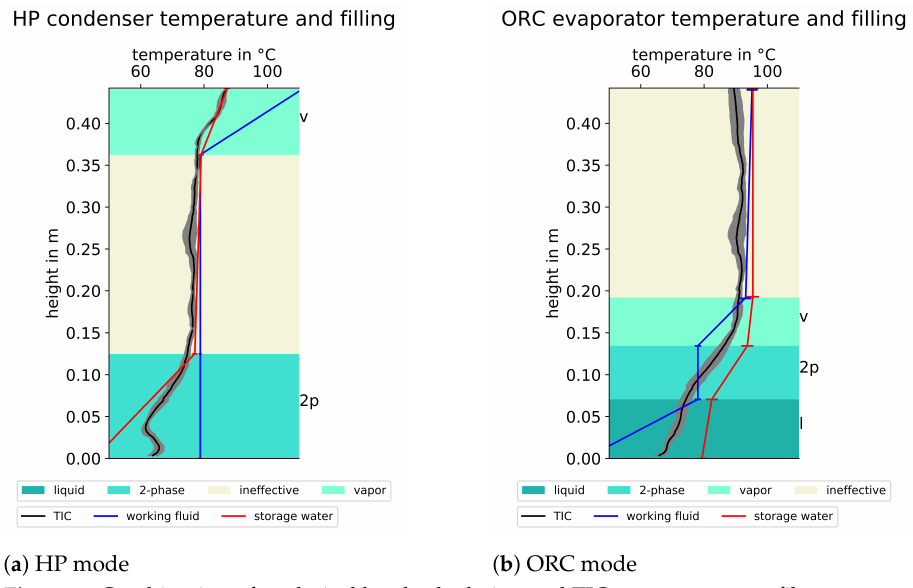
Figure 9. Combination of analytical level calculation and TIC temperature